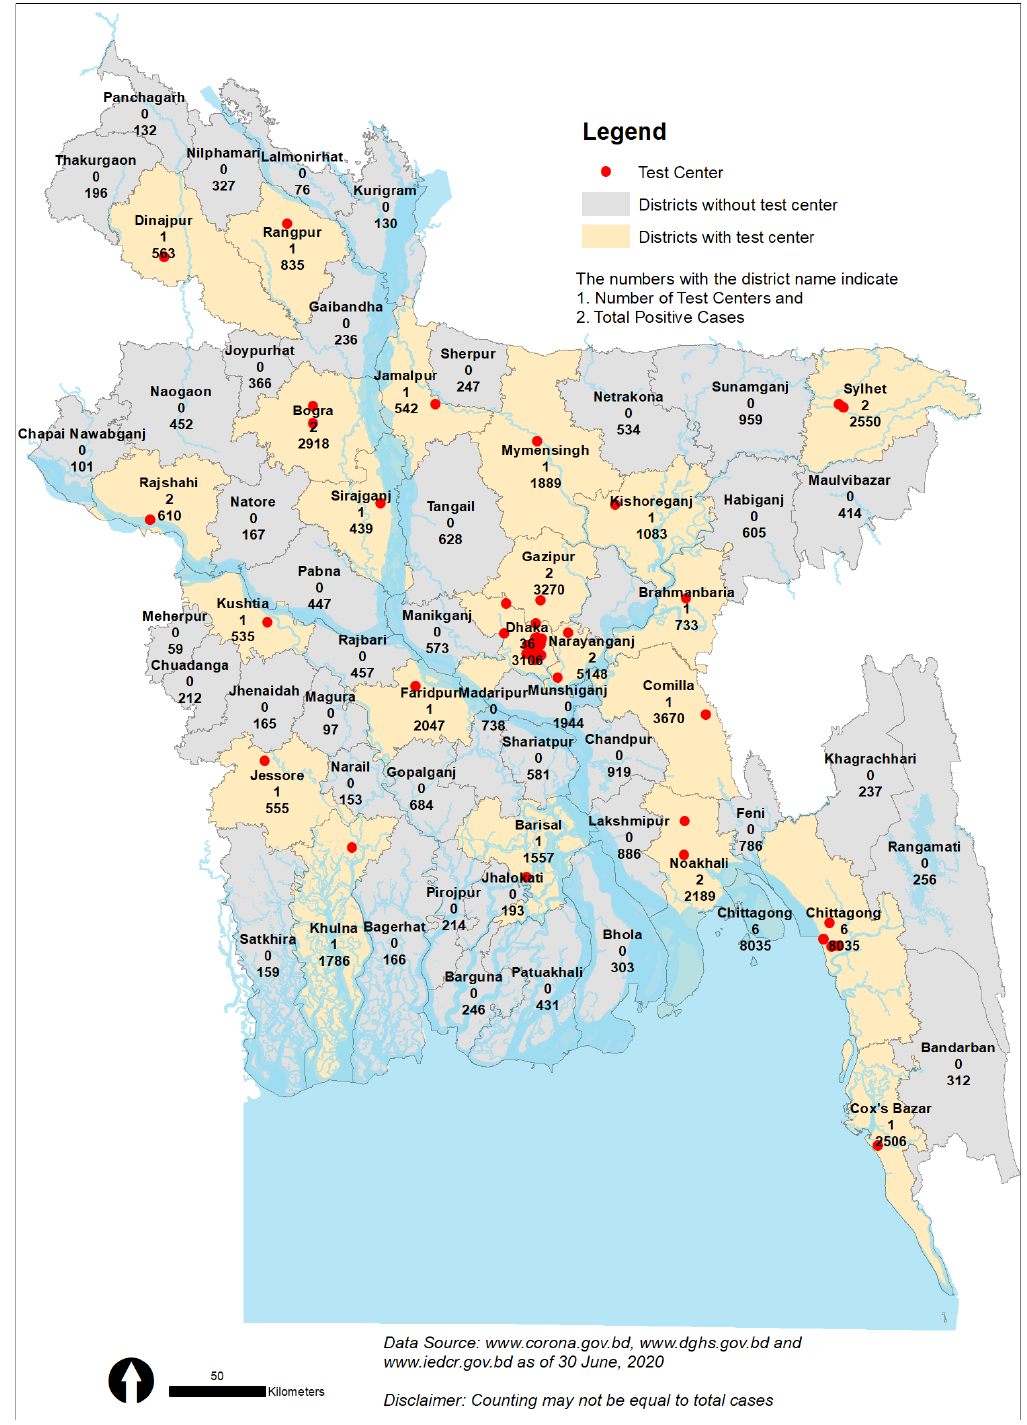
Figure6. SpatialdistributionoftestingcentersandconfirmedCOVID-19cases. Source: Authorsillustration based on the GIS and Coronavirus COVID-19 Dashboard,